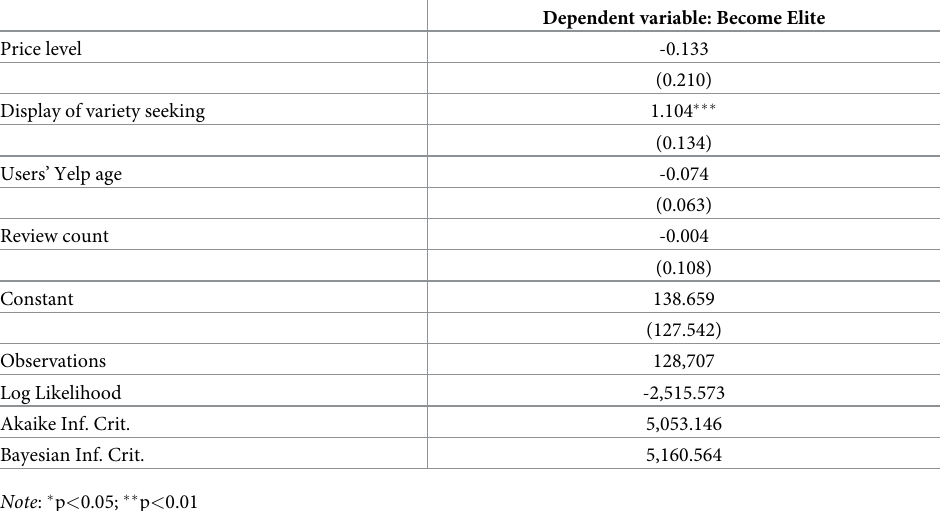
Table 2. Generalized mixed-effects model of variables predicting status